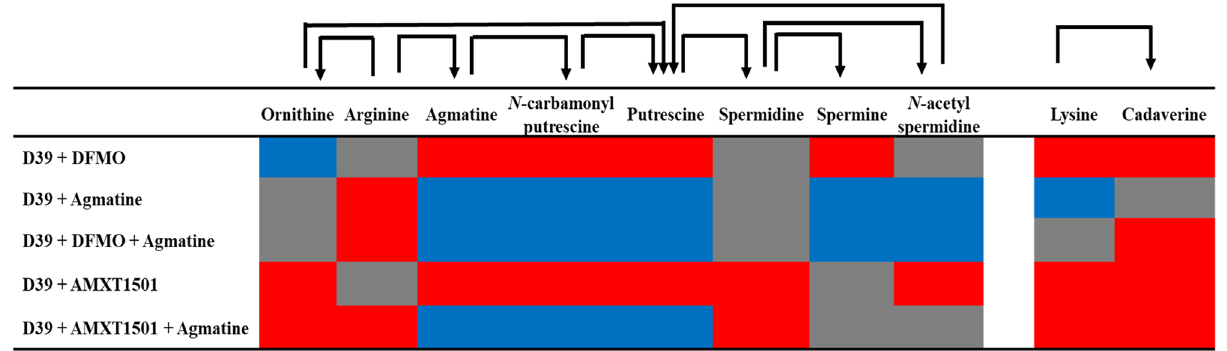
Figure 6. Impact of 1/8 MIC DFMO (34 mM), 1/4 MIC agmatine (20 mM), and 1/2 MIC AMXT 1501 (7.4 µM) on intracellular concentrations of polyamine, precursors, and intermediates in pneumococcal D39. The arrow shows the direction of substrate to intermediate to product. Metabolites in red are depleted, blue are increased, and grey are not significantly impacted.